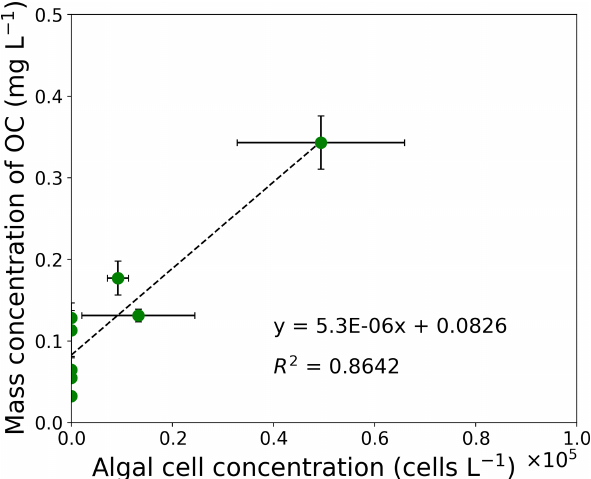
Figure 3. Correlation chart between mass concentration of OC and algal cell concentration from filed measurements at the study site. The correlation coefficient is 0.93 ( P = 8 . 0 × 10 − 4 < 0 . 05). Error bars: standard deviation.